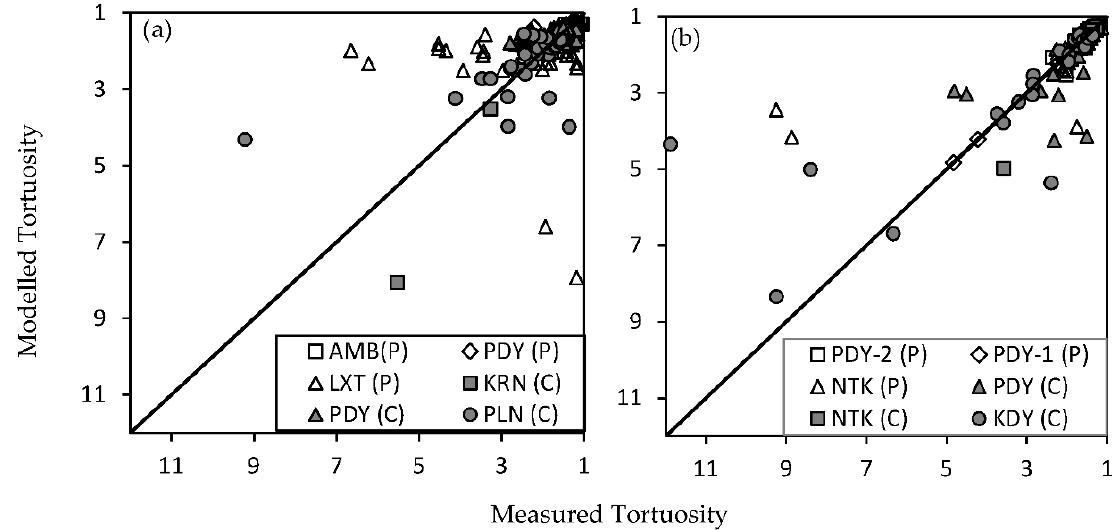
Figure 5. Pore tortuosity analysis using the two-region descriptive model (Equations (6) and (7)) for ( a ) intact and ( b ) repacked soils. AMB; Ambewela (Sri Lanka), PDY; Peradeniya (Sri Lanka), LXT; Lexington (United Kingdom), KRN; Kurunegala (Sri Lanka); PLN; Polonnaruwa (Sri Lanka), NTK; Nishi-Tokyo (Japan), KDY; Kandy (Sri Lanka). P and C in parentheses denote Pasture and Cultivated, respectively.